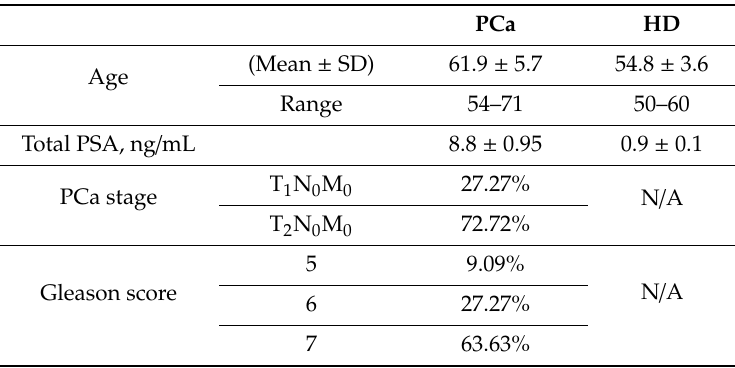
Table 1. Overview of the study